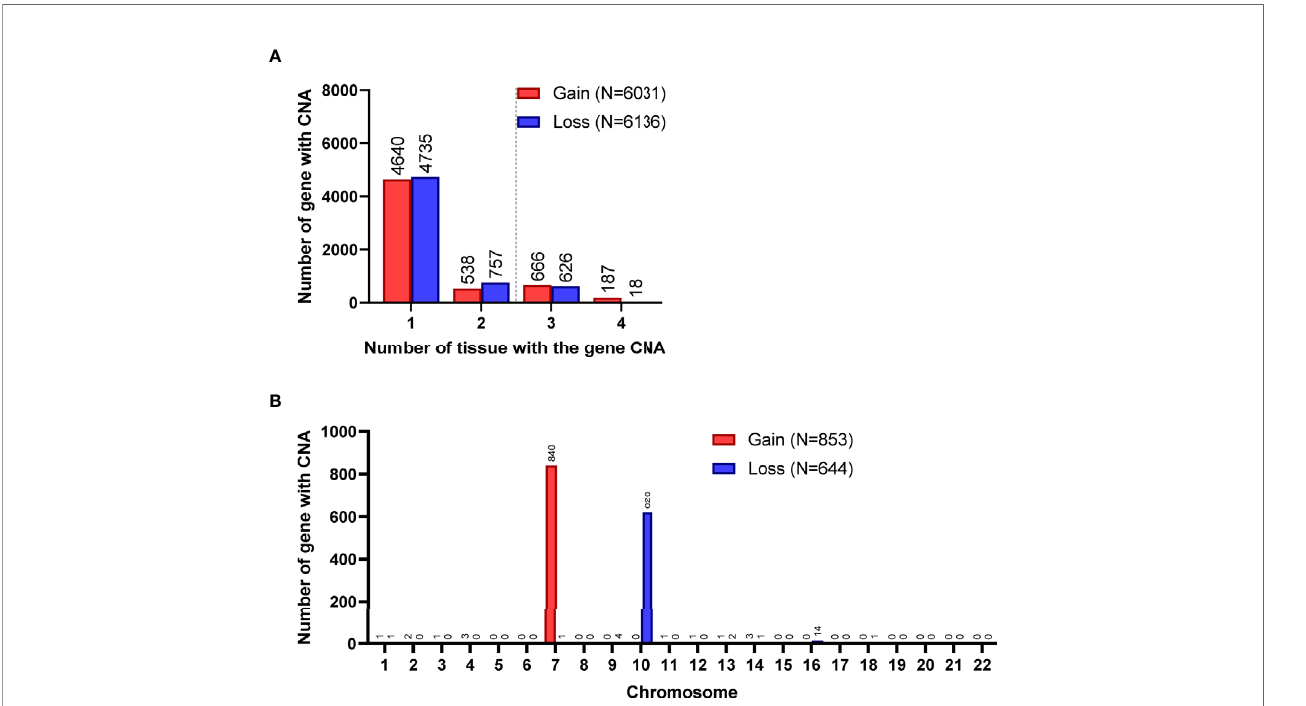
FIGURE 4 | Gene CNAs in parental GBM specimens. (A) Number of tumors contains genes with CNA in patient specimens. Genes with CNA in more than two tissue specimens were enrolled in the following studies. (B) The distribution of genes with CNA on